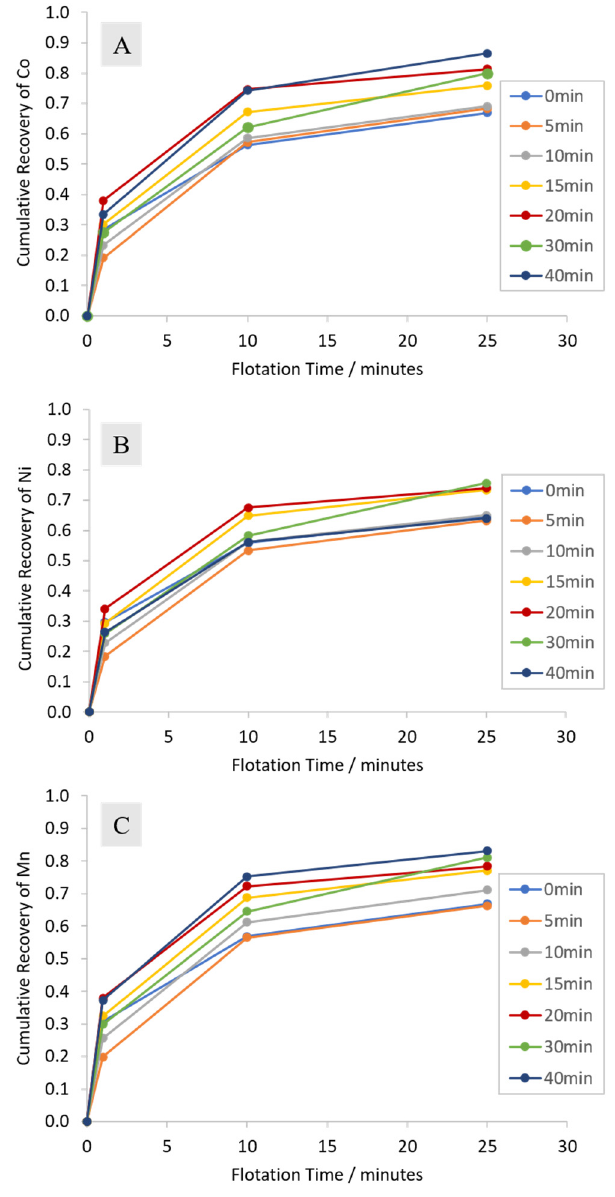
Figure 6. The cumulative recoveries of selected metals ( A ) Co, ( B ) Ni, and ( C ) Mn from cathode active materials in waste LIB after various milling times.